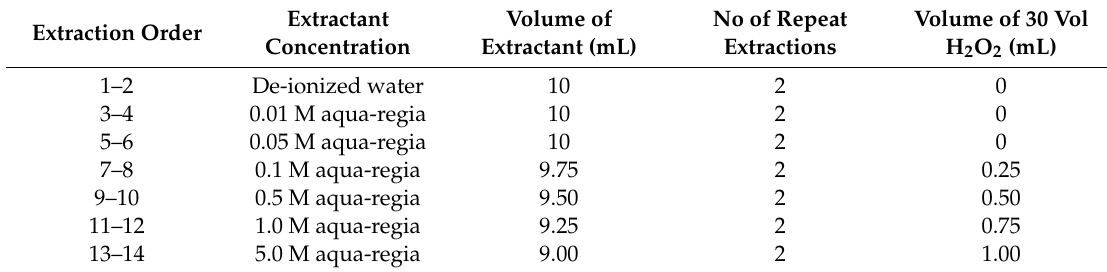
Table 1. Solutions used for the sequential